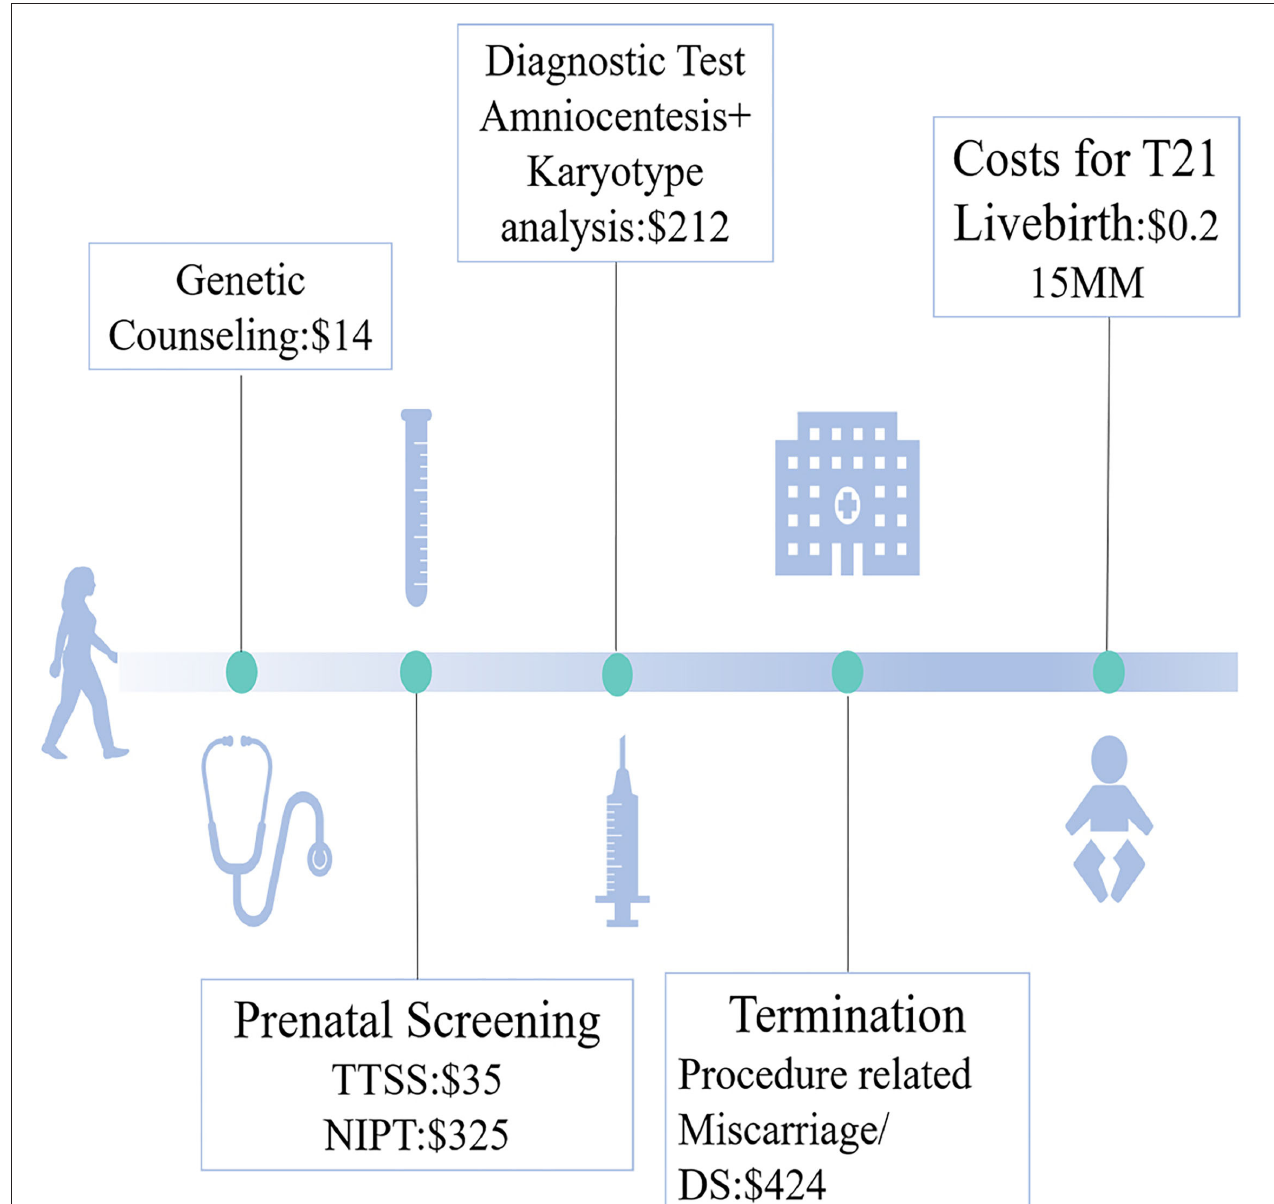
FIGURE 2 | The cost parameters during the process of prenatal care for trisomy 21 (T21)